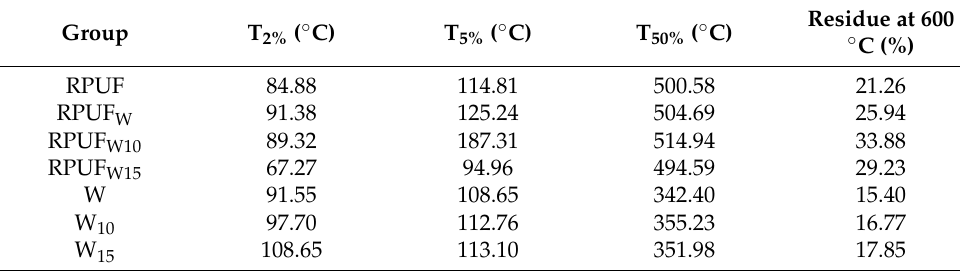
Figure 7. TG curves of the studied fillers and RPUFs. Table 2. Main TG events of the studied fillers and